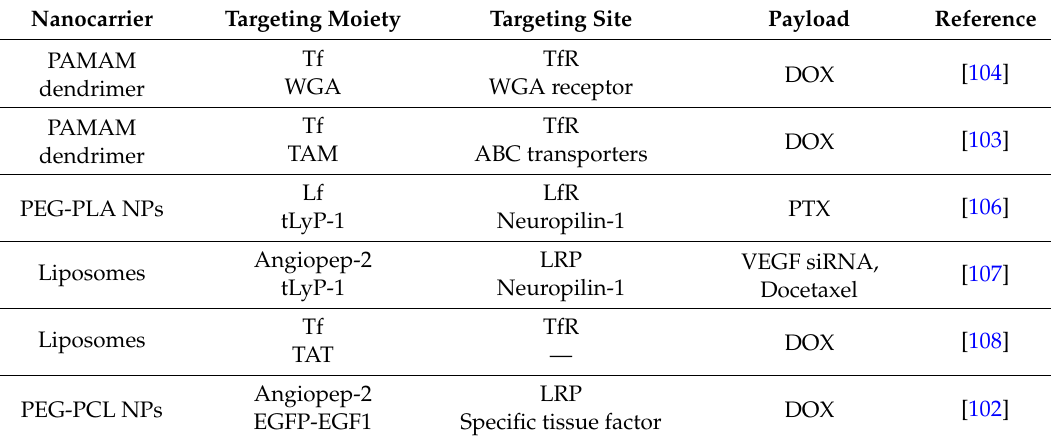
Table 2. Representative dual ligand-modified targeting